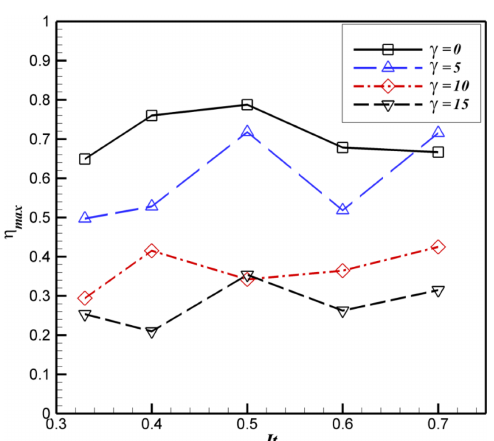
Figure 17. Variation of maximum efficiency at different immersion ratios and shaft inclination